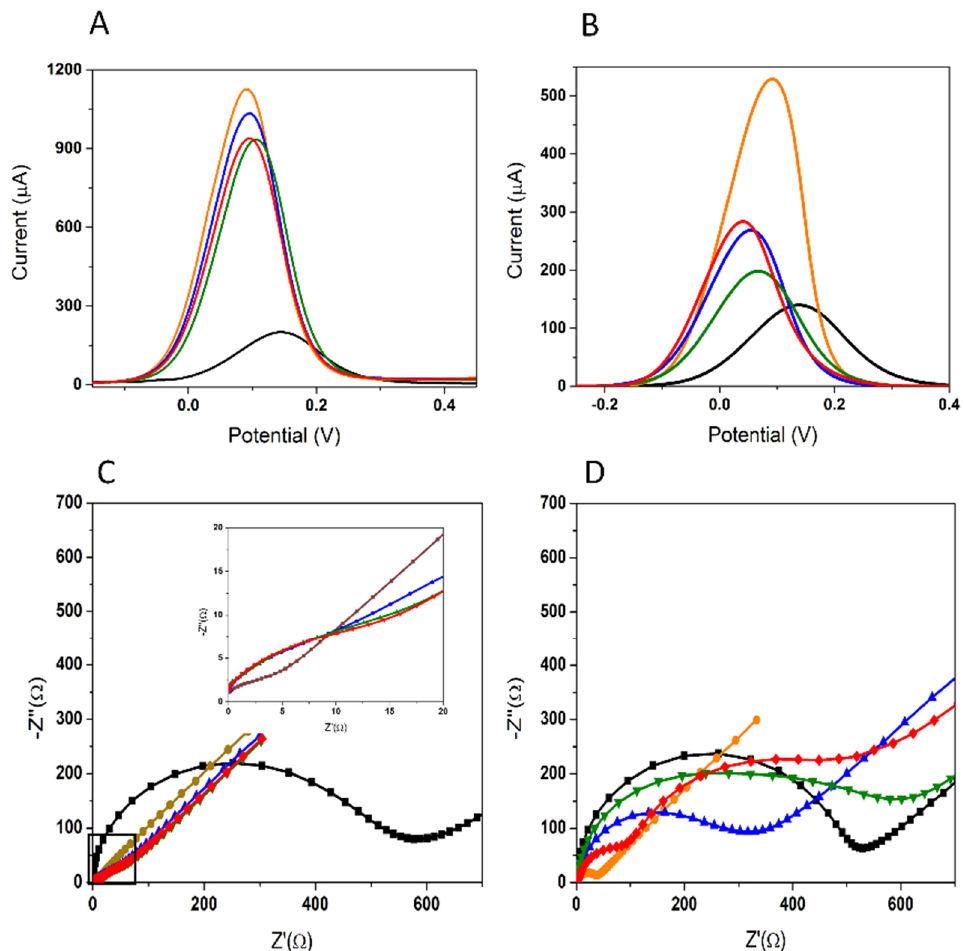
Figure 2. DPV and EIS analysis of 5 mM [Fe(CN) 6 ] 3 − /4 − on the Au-SPE platform ( A , C , respectively) and the C-SPE/AuNPs ( B , D , respectively); bare electrode ( black ); electrode activation in H 2 SO 4 ( A , C ; brown ); AuNPs deposition from 1.5 mM HAuCl 4 ( B , D ; orange ); 1 µ M APT immobilization by MPA ( blue ); 100 µ M MCH blocking by MPA ( green ); incubation with 50 µ M 3-O-C 12 -HSL for 30 min ( red ). Experimental conditions: DPV with a SR of 0.01 V s − 1 , a PH of 0.1 V, and a PW of 25 ms; and EIS with an FR from 0.01 to 100,000 Hz for a total of 50 frequencies, at open-circuit potential values.